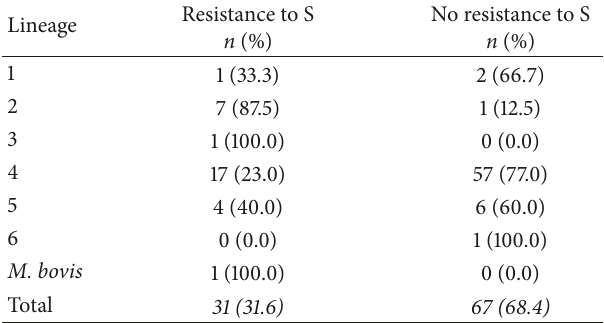
Table 5: Association between lineages and